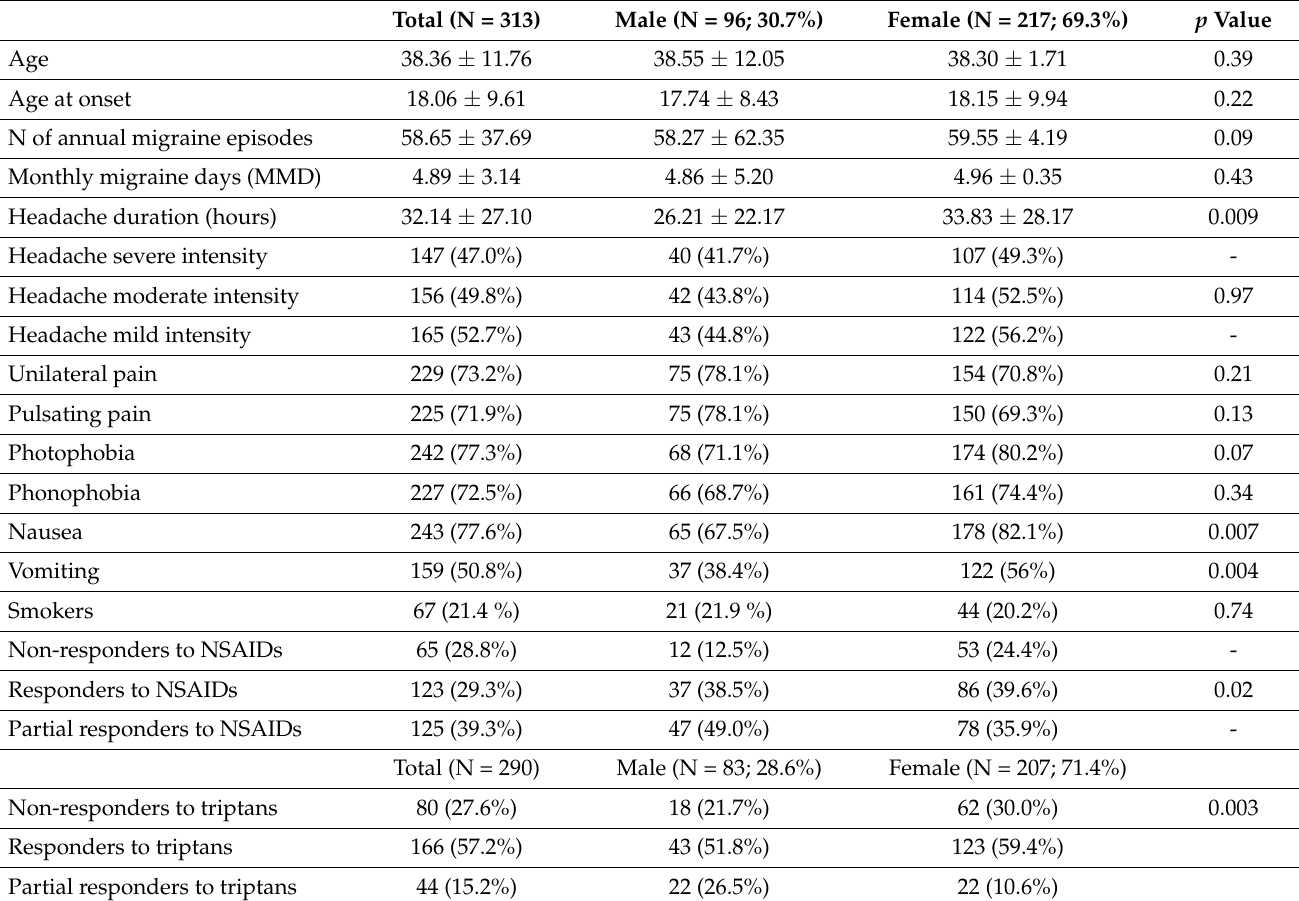
Table 1. Clinical characteristics and response to acute treatment. Data are displayed as mean ± standard deviation or count and